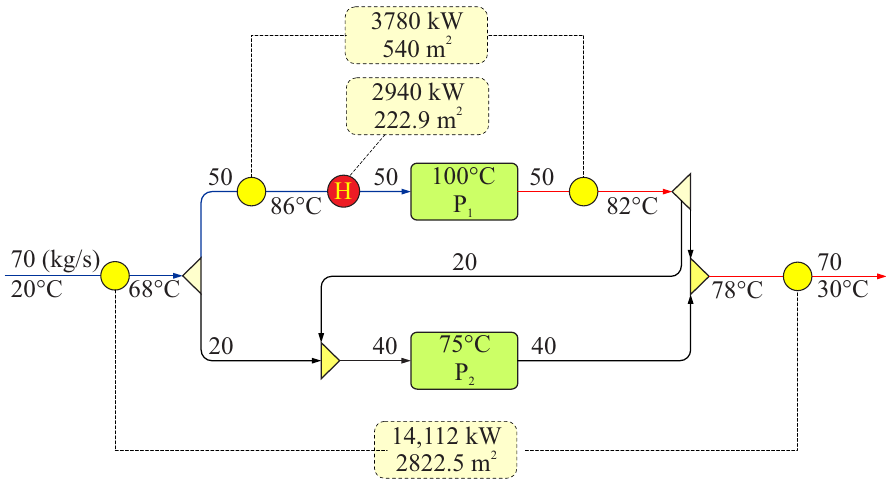
Figure 3. Optimal design of